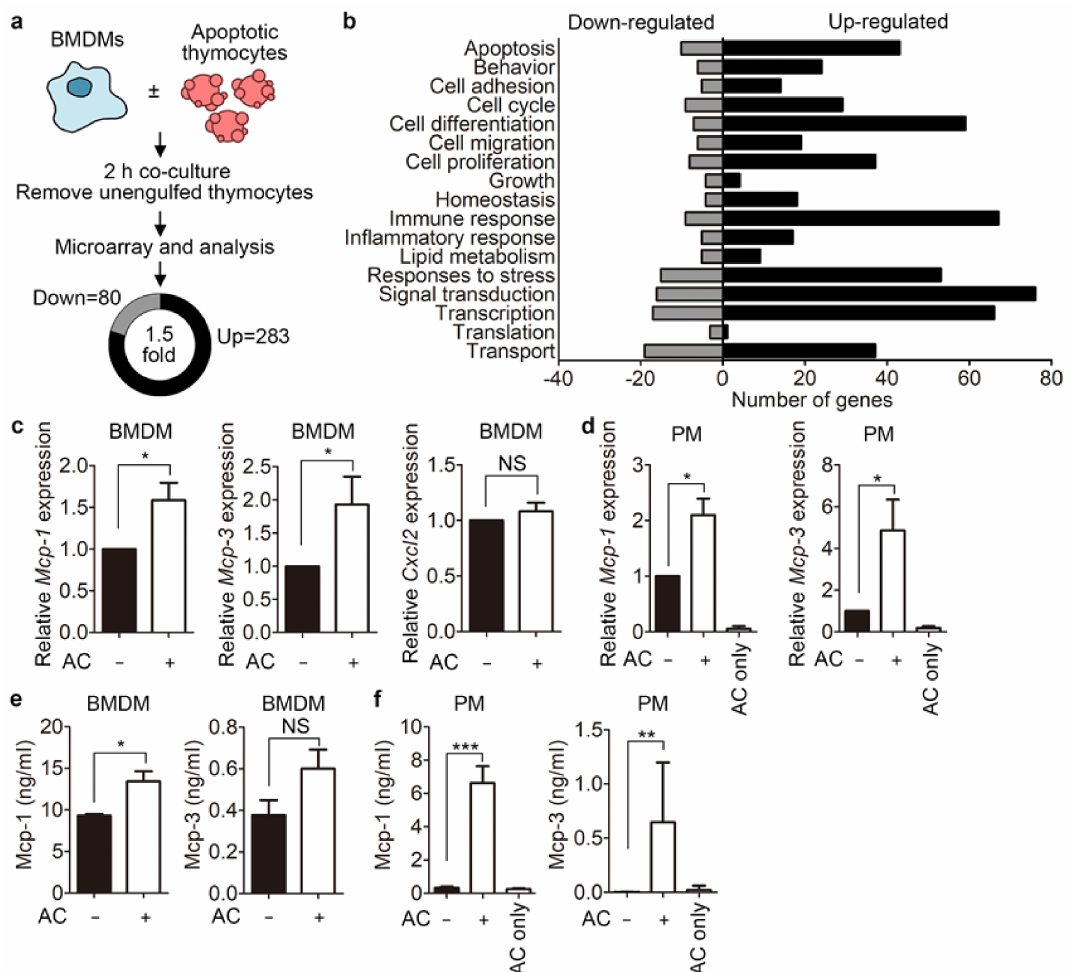
Figure 1. Mcp-1 secretion by phagocytes is augmented during efferocytosis. ( a ) Schematic diagram showing how genes regulated during efferocytosis were identified. BMDMs were incubated with or without apoptotic thymocytes for 2 h and then transcriptional changes were compared between these two samples. The numbers of up- and downregulated genes in phagocytes incubated with apoptotic cells compared with control phagocytes are shown. ( b ) Gene ontology analysis. Genes up- or downregulated more than 1.5-fold in phagocytes incubated with apoptotic cells compared with control phagocytes were categorized according to their function. BMDMs ( c ) or peritoneal macrophages ( d ) were incubated with or without apoptotic thymocytes for 2 h, and the transcript levels of Mcp-1 , Mcp-3 , and Cxcl2 (c) or Mcp-1 and Mcp-3 (d) were measured using quantitative RT-PCR. BMDMs ( e ) or peritoneal macrophages ( f ) were incubated with or without apoptotic Jurkat for 8 h, and then conditioned medium from phagocytes was collected. The protein levels of Mcp-1 and Mcp-3 were measured using an ELISA. All data are shown as the mean ± SEM. * p < 0.05, ** p < 0.01, *** p < 0.001. NS, not significant; PM, peritoneal macrophages; AC, apoptotic